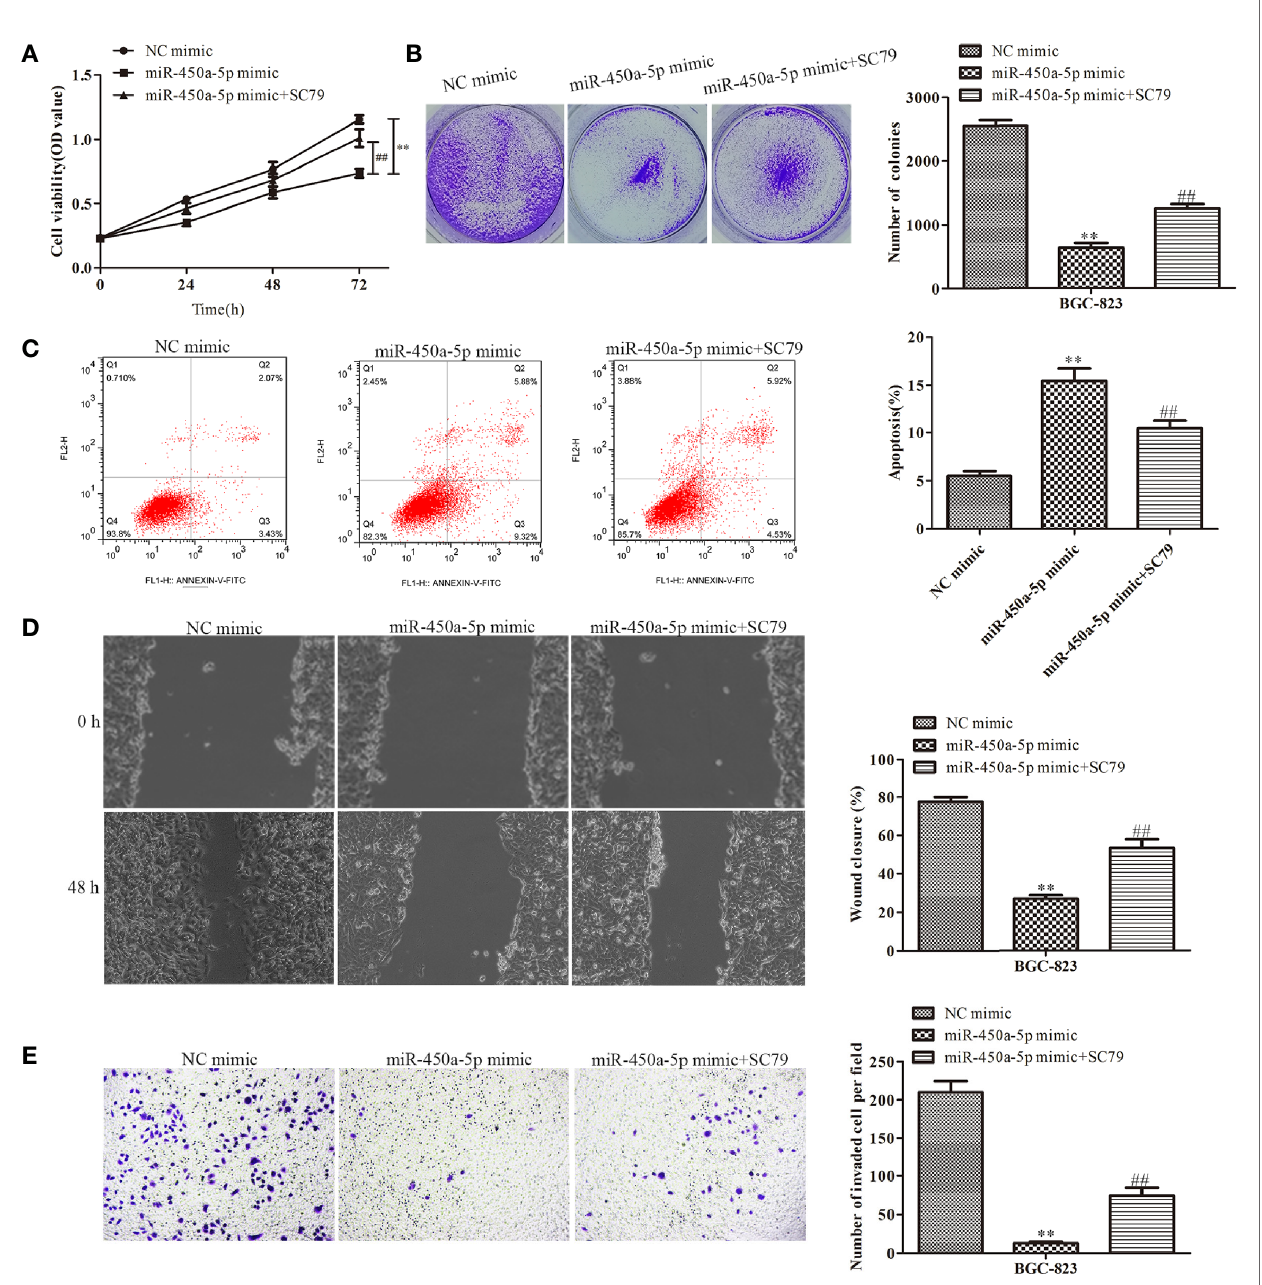
FIGURE 8 | MiR-450a-5p inhibits the progression of gastric cancer by inhibiting the AKT/GSK-3 b signaling pathway. (A, B) CCK-8 and colony formation assays on the cell proliferation of BGC-823 cells. (C) Flow cytometry on the cell apoptosis of BGC-823 cells. (D) Wound healing assay on the cell migration of BGC-823 cells after knockdown of CREB1. (E) Transwell chamber assay on the cell invasion of BGC-823 cells after knockdown of CREB1. ** P <0.01 vs. NC mimic group. ## P <0.01 vs. miR-450a-5p mimic